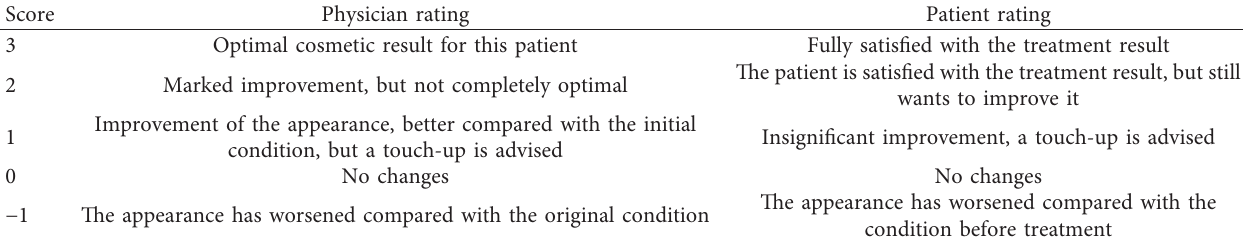
Figure 2: After one procedure (a), after two procedures with calcium hydroxylapatite injection (1.5mL) (b, c). Table 2: Ratings on the global aesthetic improvement scale